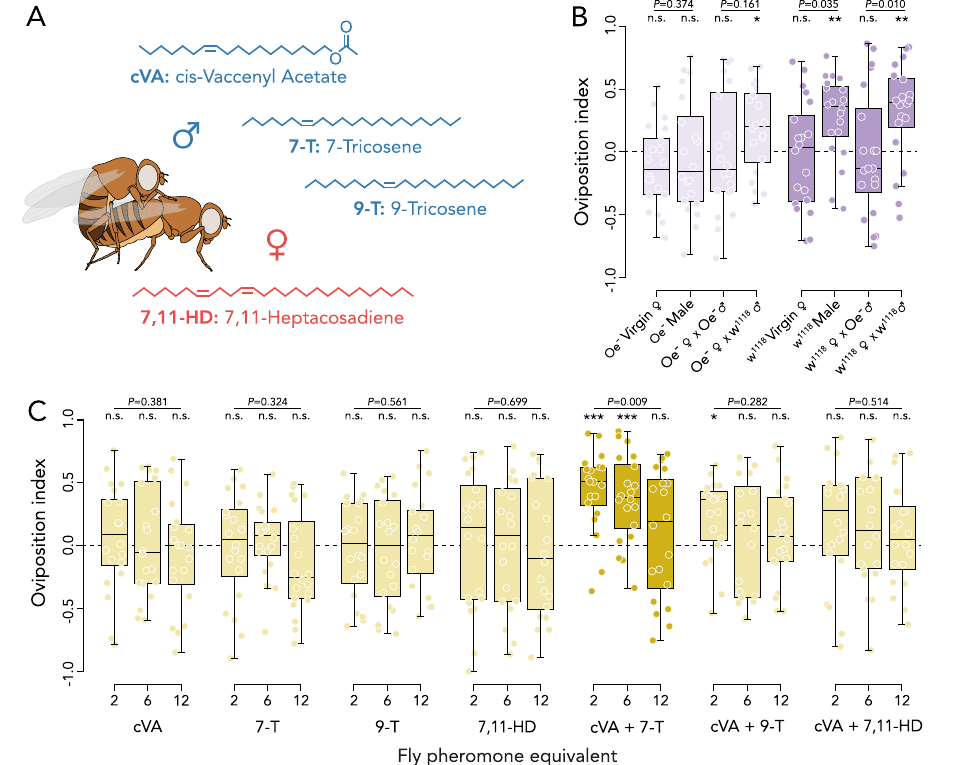
Fig. 2 | Male-derived pheromones attract mated females to oviposition sites. A Overview of the main sex-speci fi c pheromones transferred by males (blue) and females (red) during mating. B Oviposition preference to pheromone extracts of oenocyte ablated (Oe - ), w 1118 , or mated fl ies of the indicated genotypes (see Fig. Asterisks above a treatment indicates attraction differing signi fi cantly from zero